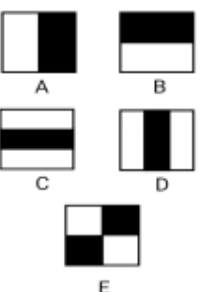
Figure 6. Haar-like feature templates.